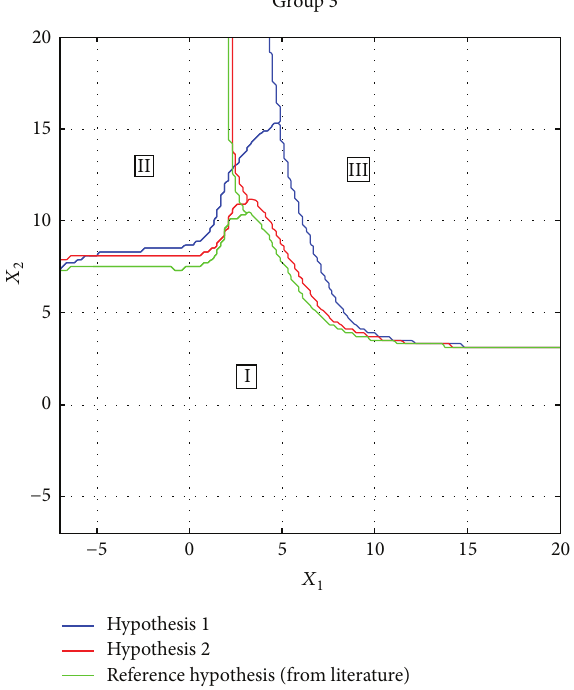
Figure 20: Production policy for 𝑃 2 and setup policy (product 2 to product 1).